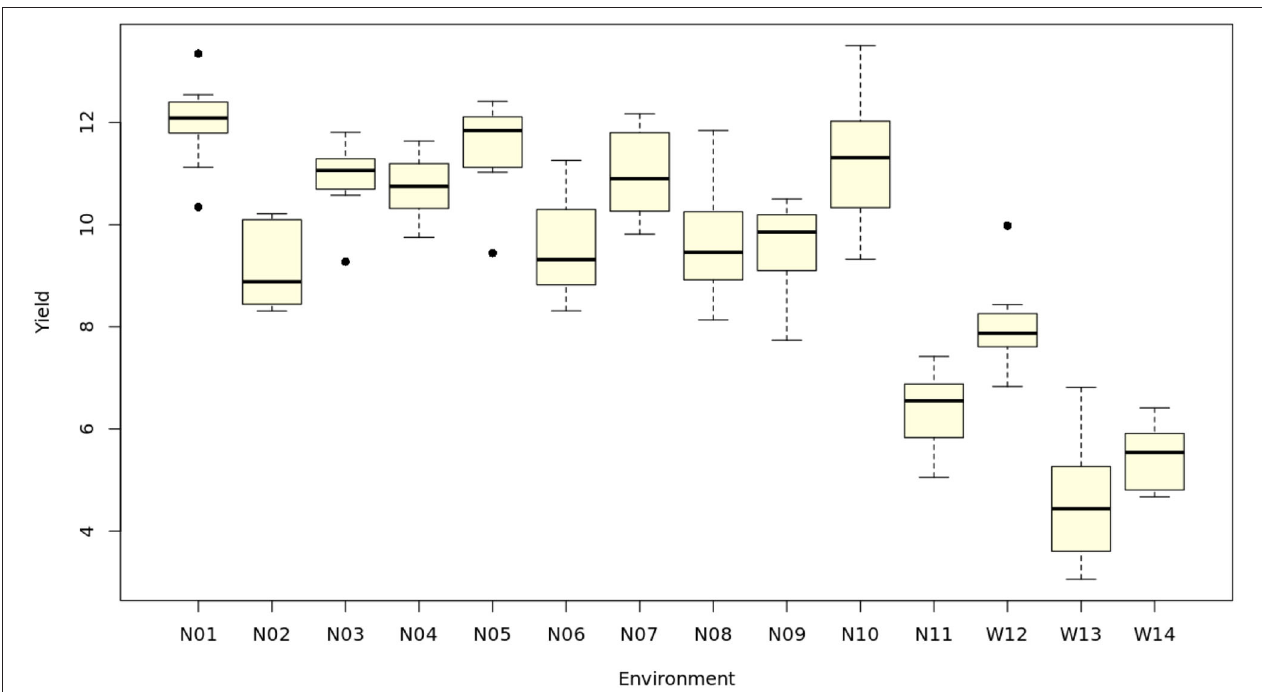
FIGURE 1 | The distribution of 10 maize genotypes on yield (t ha − 1 ) in each test